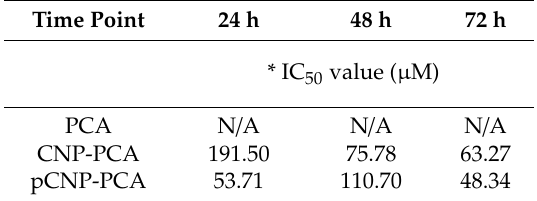
Table 3. The IC 50 values of di ff erent PCA treatments on A549 cell lines. The encapsulated PCA has greater e ffi cacy than free PCA throughout all time points. Lower IC 50 values indicate a higher cytotoxic e ffi ciency. Time